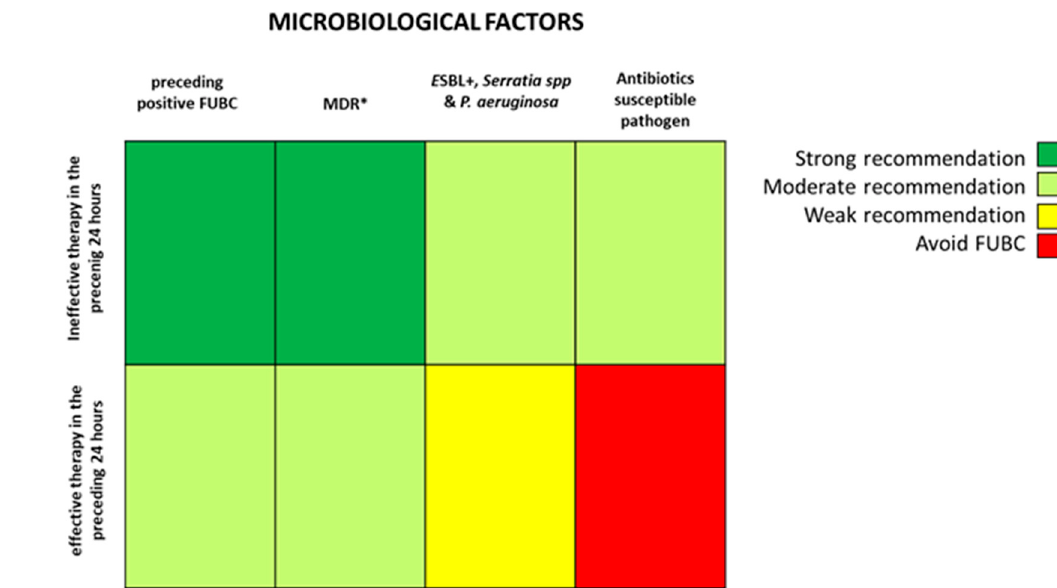
Figure 4. Flow chart of article selection process. References of eleven selected articles: [15,17–26].